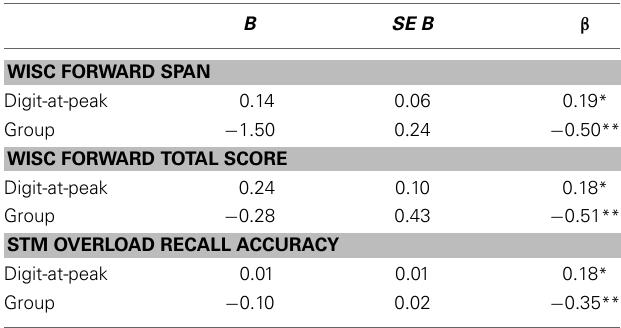
Table 2 | Multiple regression analyses for WISC score, WISC span, and recall